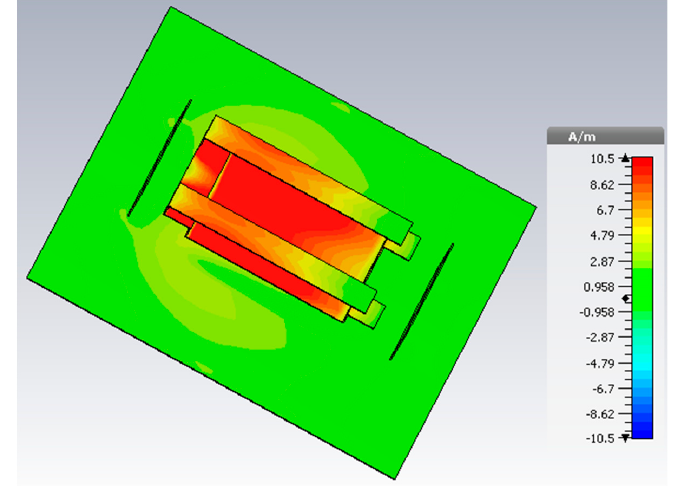
Figure 4. Surface current distribution of the antenna at 1.63 GHz.